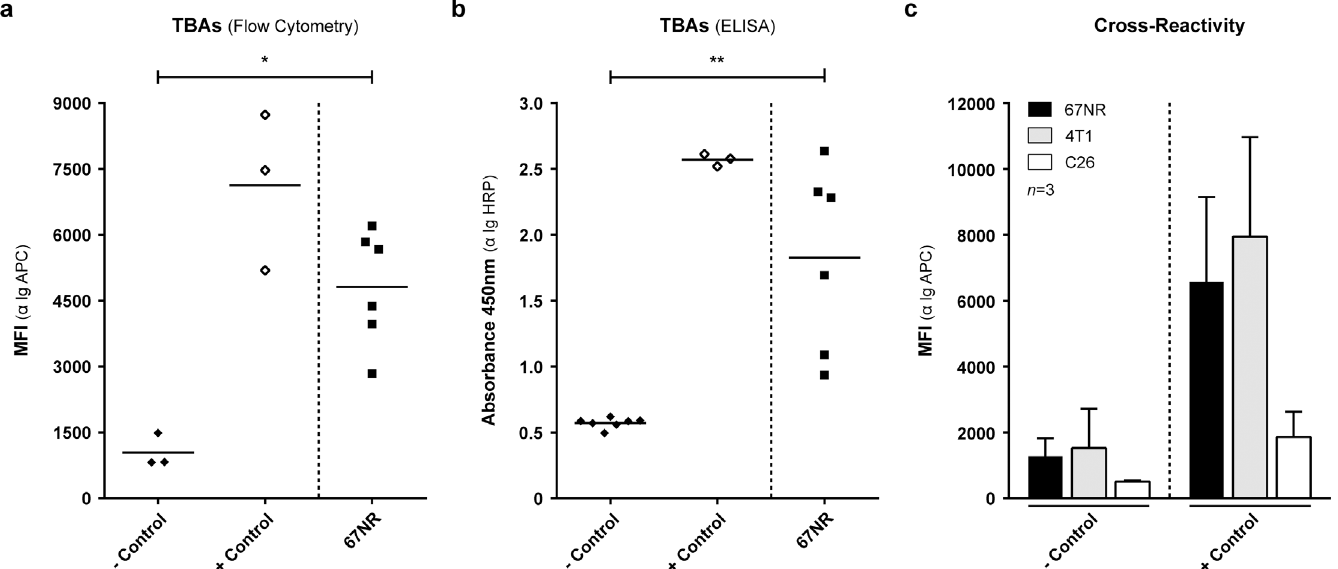
Fig 3. Detection and cross-reactivity of TBAs in the plasma of immunocompetent, vaccinated, and 67NR tumour-bearing Balb/C mice. a, b. Detection of TBAs in the plasma of immunocompetent (-control), vaccinated (+control), and 67NR tumour-bearing mice using cellular flow cytometry ( α Ig APC) and ELISA ( α Ig HRP) based systems. Mann-Whitney t-test with P < 0.05 * and P < 0.01 ** . c. To determine whether the antibodies are 67NR specific, 1 * 10 5 murine 67NR, 4T1 (mammary), and C26 (colon) carcinoma cells were incubated with plasma from -control and +control Balb/C mice to determine the cross-reactivity of plasma containing antibodies. MFI: mean fluorescent